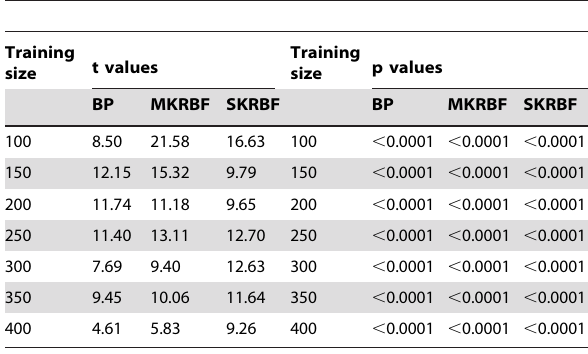
Table 1. Two-tailed Student T test between MSRBF and other